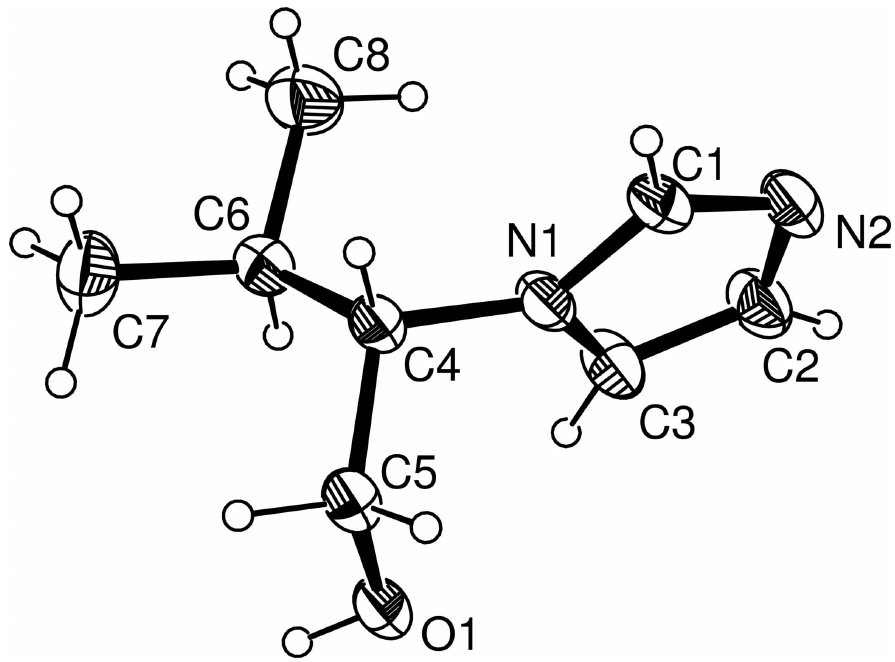
Figure 1 The molecular structure of (I), showing 30% probability displacement ellipsoids and the atomic numbering. rac-( S )-2-(1 H